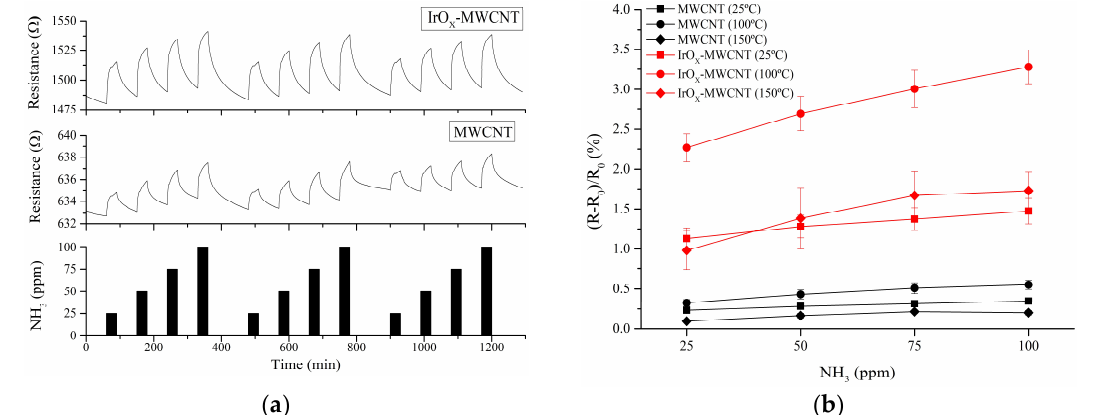
Figure 4. Typical resistance response obtained when detecting NH 3 at a sensor operating temperature of 100 °C ( a ). Calibration curves obtained for NH 3 at different operating temperatures ( b ).